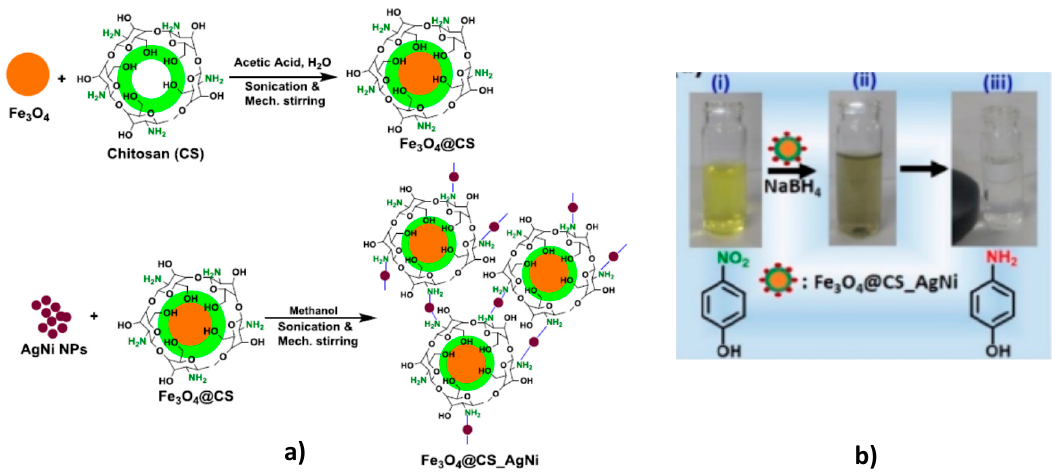
Figure 14. Synthetic protocol of preparation of Fe 3 O 4 @CS and Fe 3 O 4 @CS / AgNi core-shell structure ( a ) and reduction of 4-NP accompanied by separation of Fe 3 O 4 @CS / AgNi using an external magnet ( b ). (Reprinted from [58]).